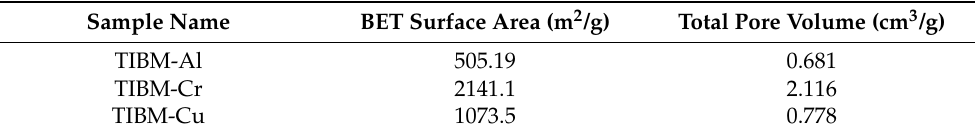
Figure 1 . ( a ) N 2 adsorption isotherms and ( b ) pore size distribution of TIBM-Al, TIBM-Cr, and MOF- Cu at 77 K . Table 1. Surface area and pore volume of TIBM-MOFs. Table 1. Surface area and pore volume of TIBM-MOFs.